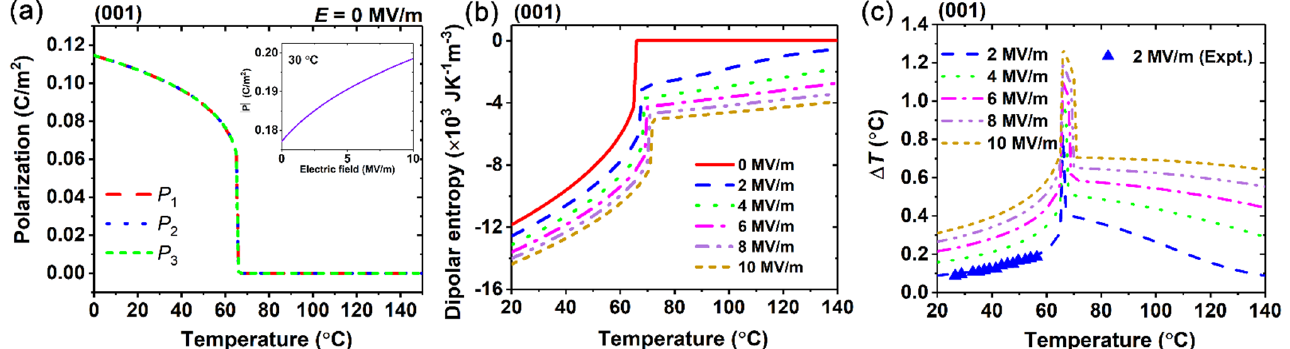
Figure 1. ( a ) Polarizations of (001)-oriented BaZr 0.15 Ti 0.85 O 3 in the absence of an external electric field, and modulus of polarization vector as electric field increases at 30 °C. ( b ) Dipolar entropy and ( c ) adiabatic temperature change Δ T under different electric fields as a function of temperature. Experimental data are denoted by blue triangles [21].